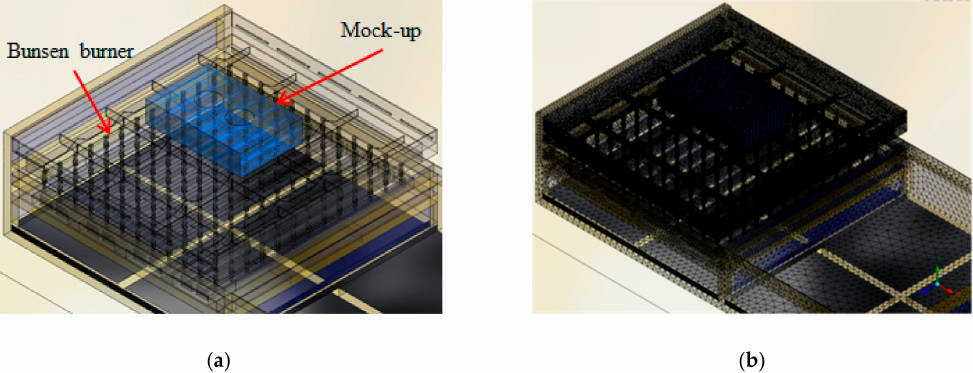
Figure 8. Geometry of prototype apparatus ( a ) and its grid system using tetrahedral ( b